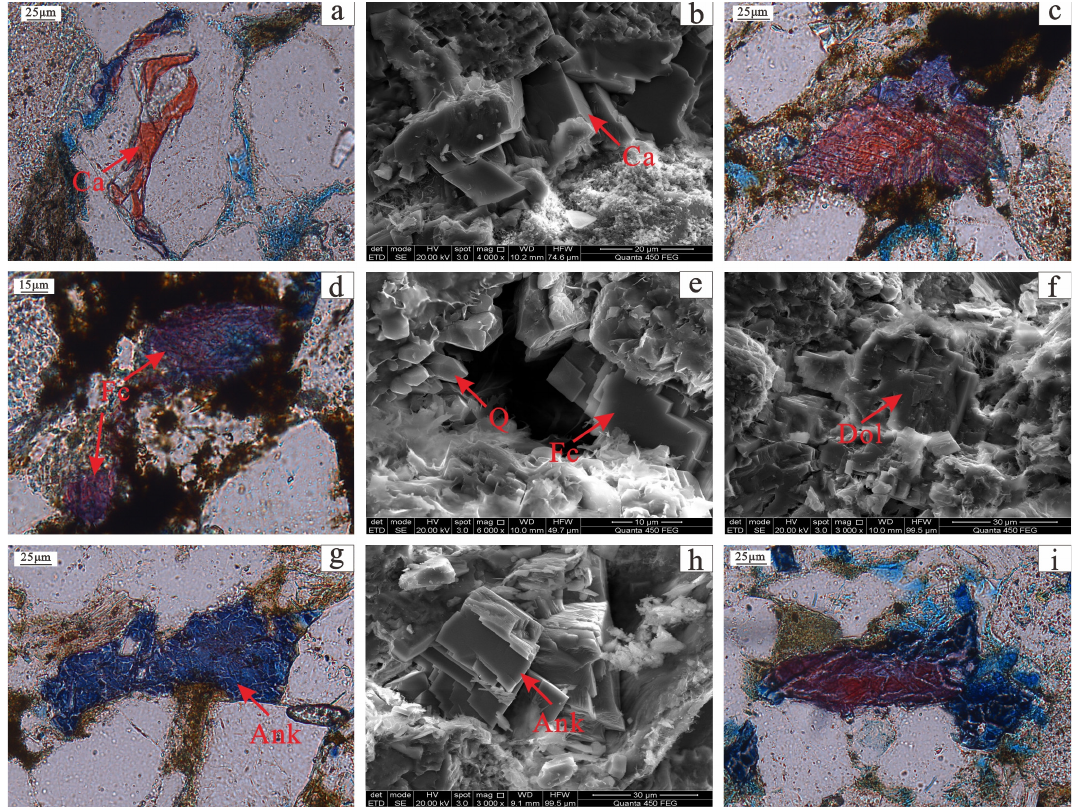
Figure 6. Carbonate cementation of the Chang-7 Member in the Ordos Basin (Q: quartz; Ca: calcite; Fc: ferroan calcite; Dol: dolomite; Ank: ankerite). ( a ) M27, 2745 m, calcite-filled pores; ( b ) Y474, 2221.3 m, inlaid cemented calcite; ( c ) X291, 2020.8 m, cementation of calcite and ferroan calcite; ( d ) L337, 2284.3 m, ferroan-calcite-filled pores; ( e ) Z230, 1743.9 m, ferroan-calcite-filled pores; ( f ) N142, 1687.8 m, dolomite; ( g ) X288, 2116.4 m, ankerite-filled pores; ( h ) L304, 2489.6 m, ankerite-filled pores; ( i ) L285, 2172.7 m, cementation of ferroan calcite and ankerite.